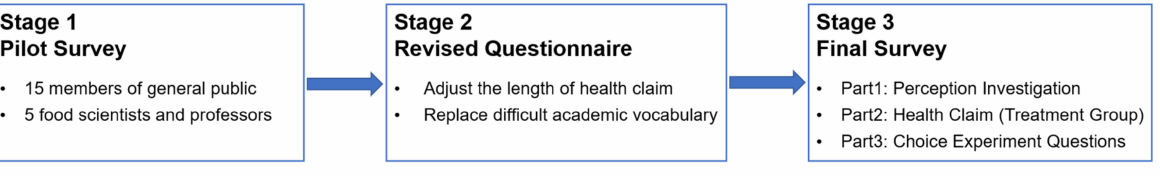
Figure 3. Different stages of research